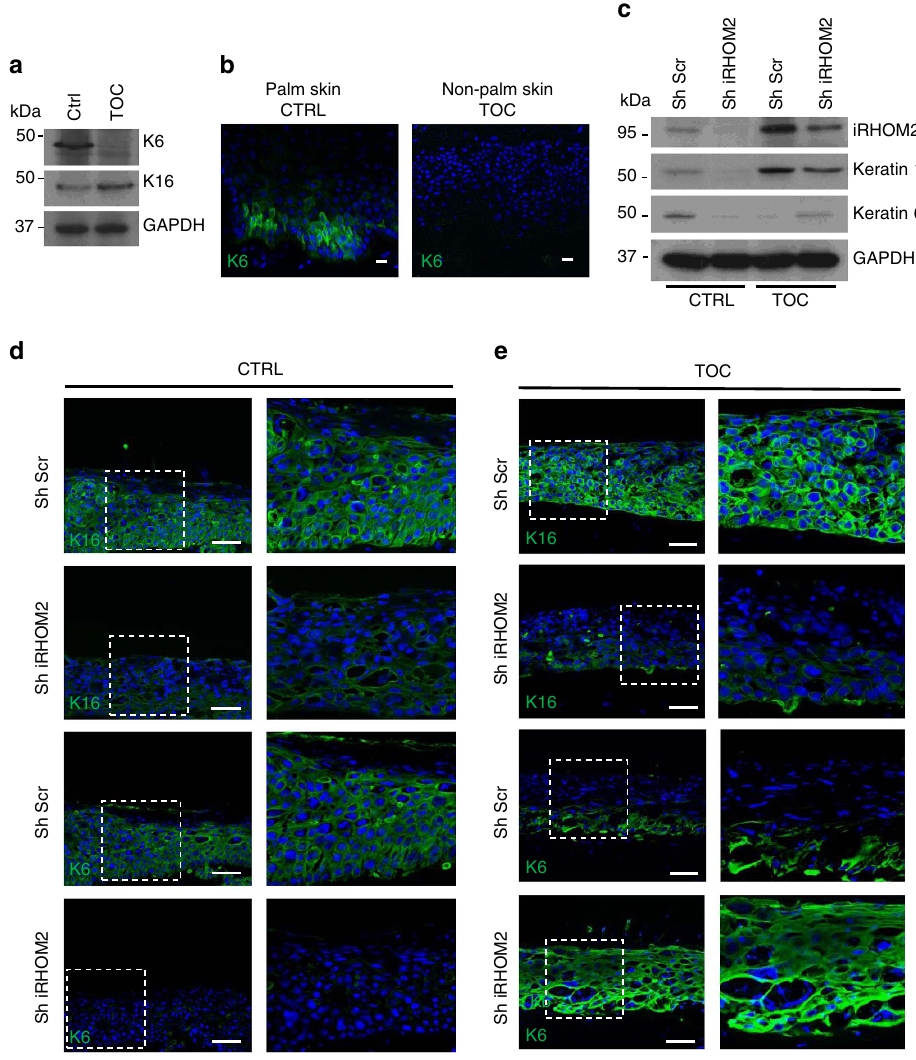
Figure 3 | K16 and K6 are differentially regulated in TOC. ( a ) Western blot analysis of endogenous expression of K16 and K6 in CTRL and TOC keratinocytes. GAPDH was used as a loading control. ( b ) Confocal analysis performed on palm skin (positive control) and non-palmar TOC skin shows diminished K6 expression in the TOC epidermis. Scale bars, 20 m m. ( c ) Western blot analysis showing that IRHOM2 depletion by shRNA reduces the expression of K16 in CTRL and TOC keratinocytes, while it restores expression of K6 in TOC keratinocytes. GAPDH was used as a loading control. ( d ) Confocal analysis showing the reduction of K16 and K6 expression in Sh-iRHOM2 CTRL 3D human skin equivalents. Scale bars, 20 m m. ( e ) Confocal analysis showing the reduction of K16 expression but upregulation of K6 in Sh-iRHOM2 TOC 3D human skin equivalents. Scale bars, 20 m